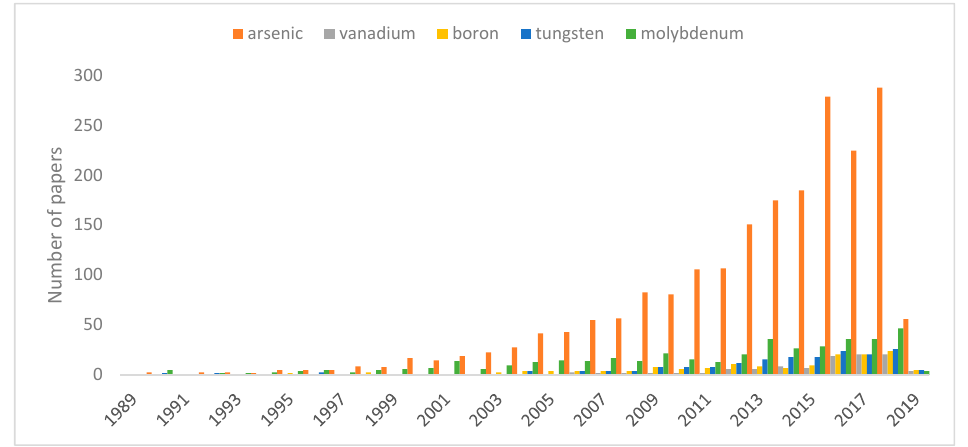
Figure 9. Mechanism of metal oxyanions adsorption onto metal (hydr)oxide-based sorbents.